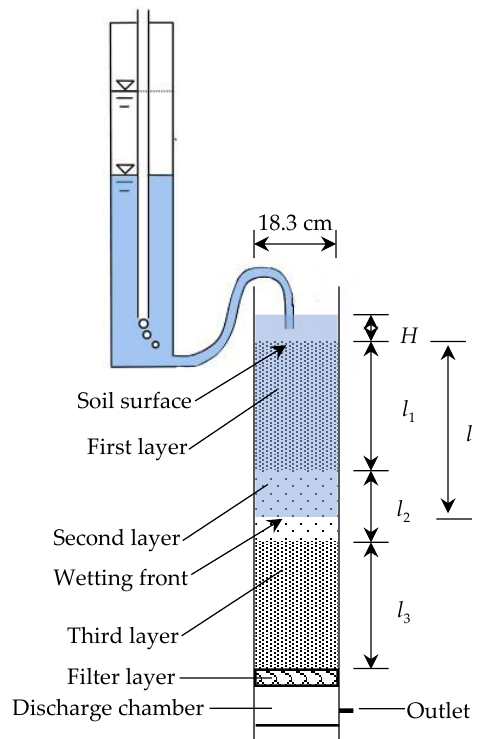
Figure 1. Schematic representation of the laboratory infiltration experiment.